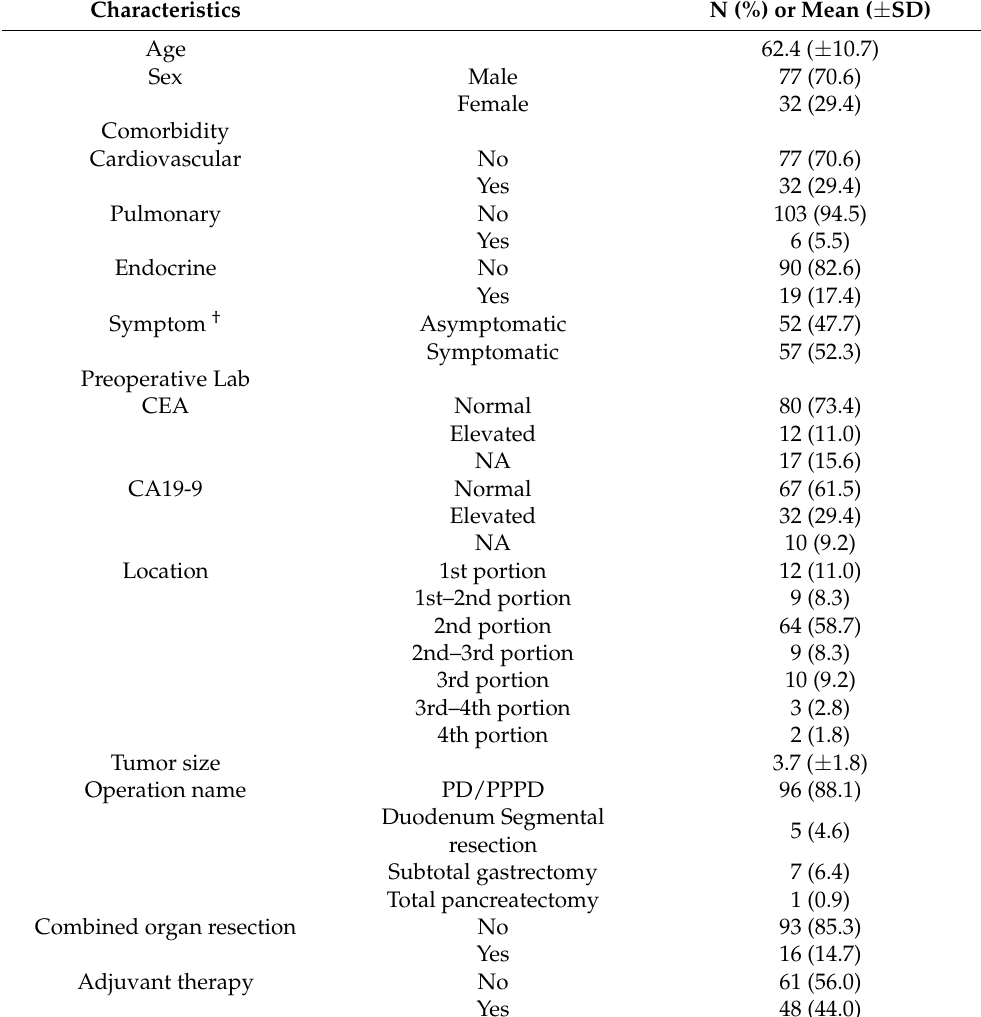
Table 1. Demographic and clinical characteristics ( n =